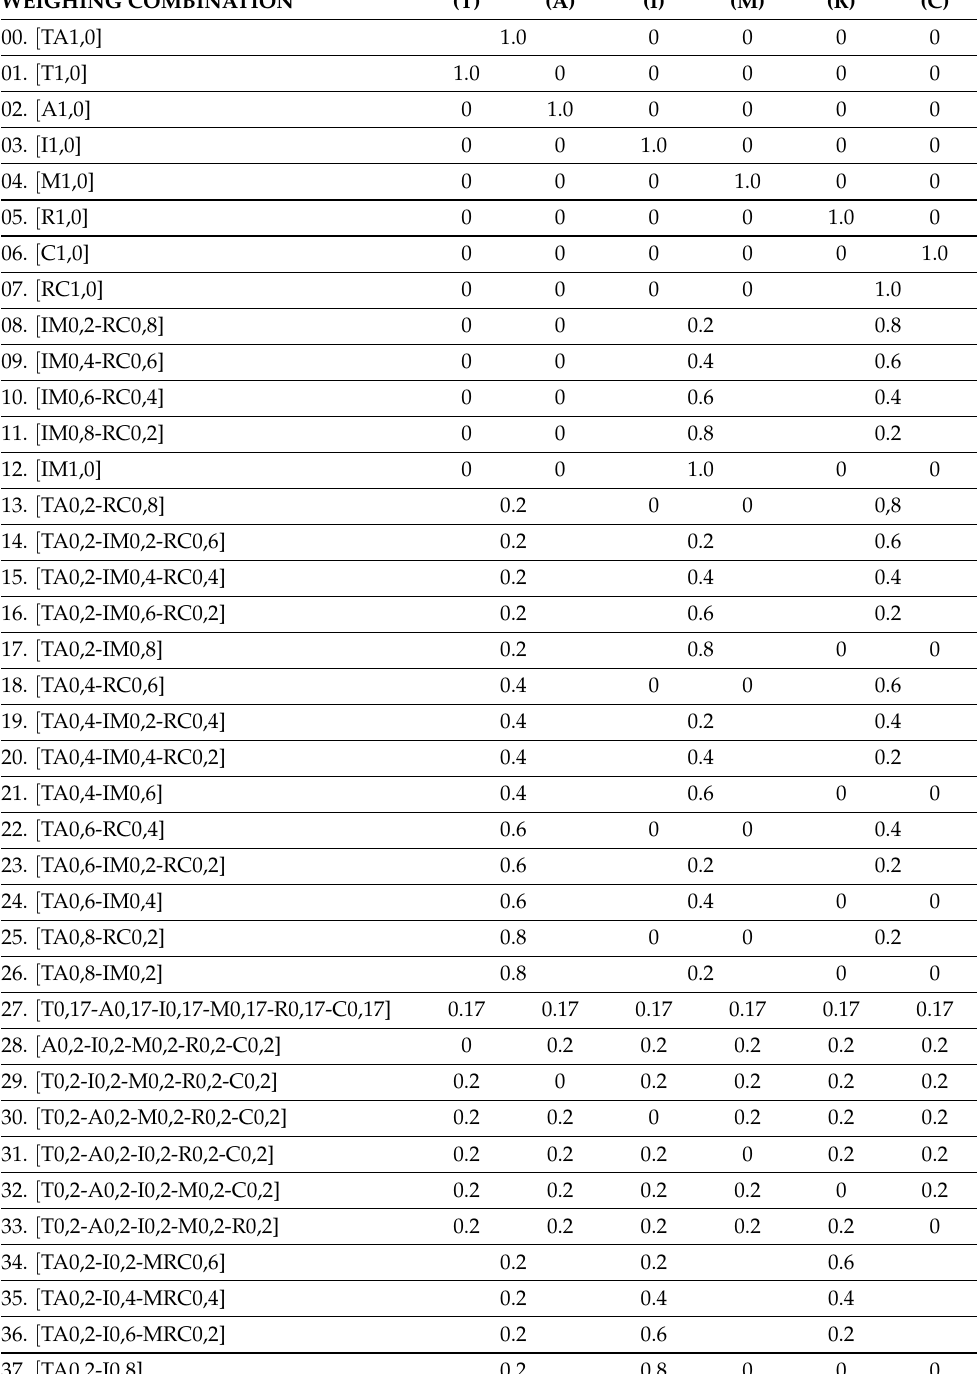
Table 2. Weighing of sections: Title (T), Abstract (A), Introduction (I), Methods (M), Results (R), and Conclusions